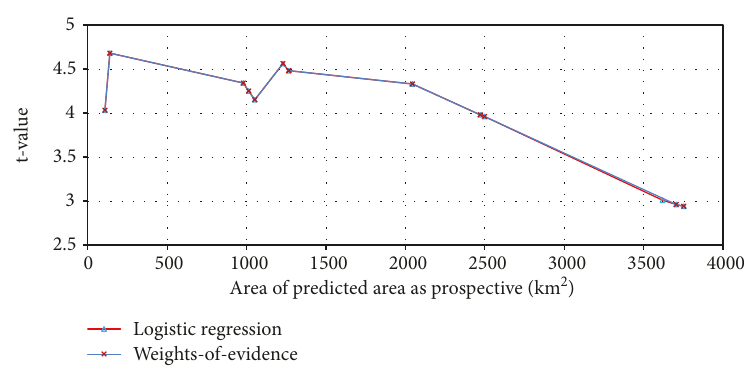
Figure 4: t values for weights of evidence and logistic regression in experiment 1.